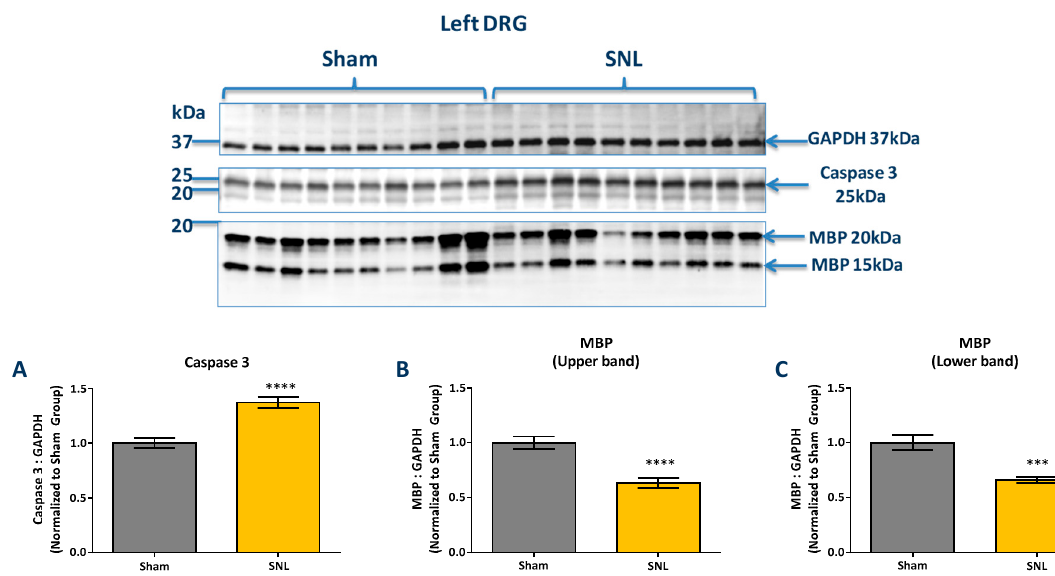
Figure 7. Comparison of Caspase-3 and MBP protein levels in in the ipsilateral DRG for sham and vehicle groups. ( A ) Caspase-3 protein levels (via western blot) in the left (ipsilateral) DRG significantly increased in the vehicle group compared to the sham. ( B ) MBP levels (via western blot) significantly decreased for both the upper band (20 kDa) and ( C ) lower band (15 kDa) in the vehicle group of the left (ipsilateral) DRG as compared to the sham. Protein level is presented normalized to GAPDH and relative to the sham group. Data presented as the average ± SEM. An unpaired t-test was performed: ***, p < 0.001; ****, p < 0.0001. 2.4. Protein Level Changes in the DRG 20 Days after SNL-Surgery (D5) between AQU-118 and Vehicle Groups MBP (both higher and lower molecular weight bands ) and caspase-3 protein levels were measured via western blotting of tissue obtained from the left (ipsilateral) DRG of the AQU-118 group ( n = 20) and compared with the vehicle ( n = 20). All protein targets were normalized to glyceraldehyde-3-phosphate dehydrogenase (GAPDH) protein levels. In the samples from AQU-118 treated animals, caspase-3 levels were significantly decreased in the ipsilateral DRG but there were no significant changes observed in the levels of MBP as compared to samples obtained from vehicle- treated animals (Figure 8). The DRG samples were tested for MMP-2 mRNA expression levels and retested for caspase-3 protein levels in the AQU-118 ( n = 10) and vehicle ( n = 10) groups. (Figure 9). Comparison of these samples showed that the AQU-118 ( n = 10) group exhibited a statistically significant decrease in the caspase-3 protein level as compared to the vehicle group ( n = 10), while still exhibiting elevated MMP-2 mRNA expression levels (Figure 9).